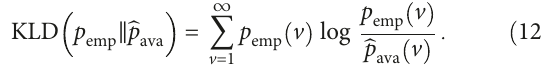
Figure 5: Total variation distance between the empirical and estimated avalanche distributions as a function of the dichotomization threshold (ignoring P